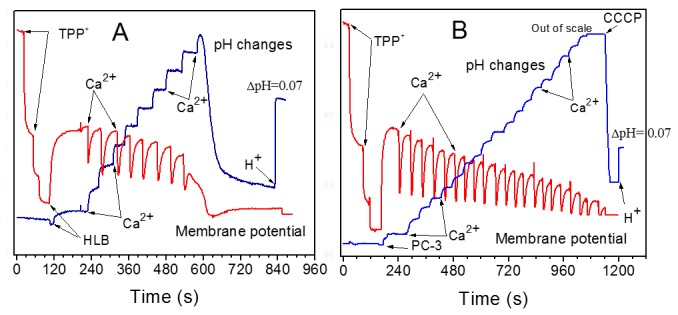
Effect of cyclosporine A on changes in membrane potential (red) and medium pH (blue) during titration of mitochondria with calcium.(A) Human lymphoblast mitochondria. (B) Mitochondria from PC-3 prostate cancer cells. Incubation conditions as in Figure 8, except that 0.5 µM CsA was present. Additions: TPP+ was added in 0.5 µM aliquots, final concentration 1.5 µM; Ca2+ 20 nmol/ml, CCCP 0.5 µM, HCl 125 nmol/ml caused ΔpH of 0.07.